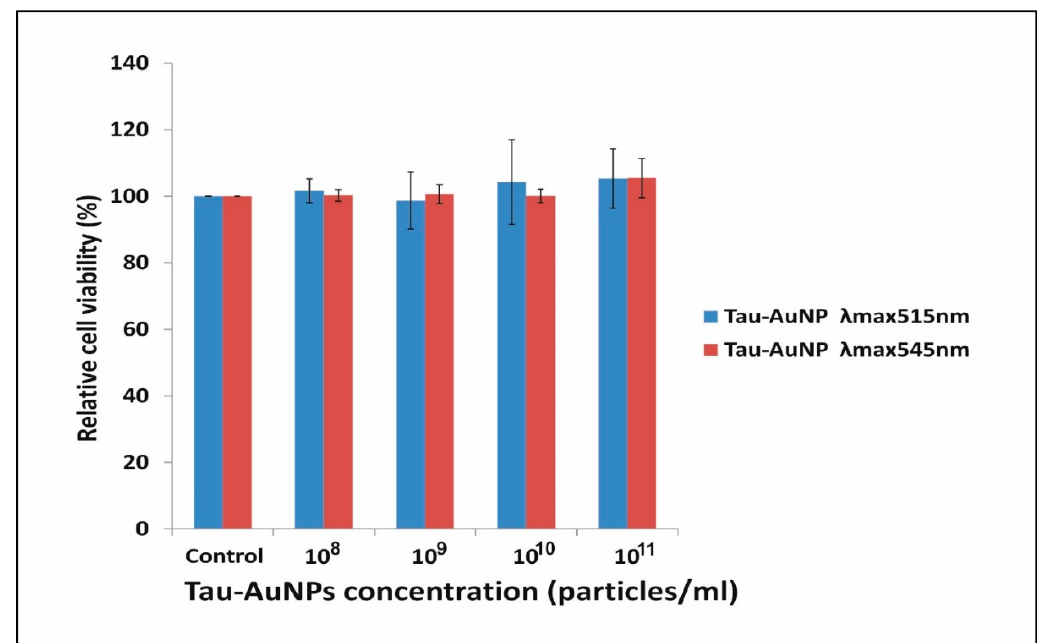
Figure 8. In vitro cell viability assessment of taurine-capped gold nanospheres with absorbance λ max 515 nm and λ max 545 nm by using an MTT assay. Liver carcinoma cells (HepG2) were exposed to different concentrations (particles/mL) of gold nanospheres with different